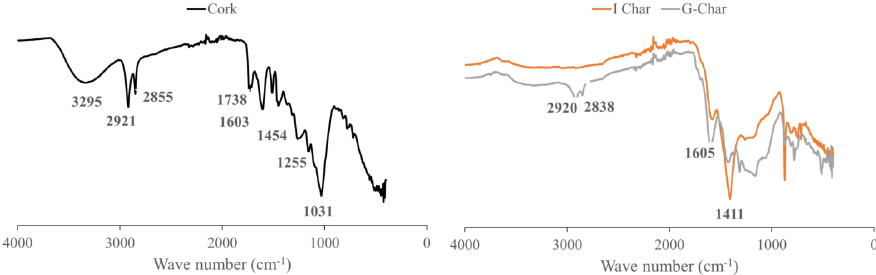
Figure 5. The effect of temperature on the surface groups of Quercus cerris cork (left) and Quercus cerris cork biochars (right).